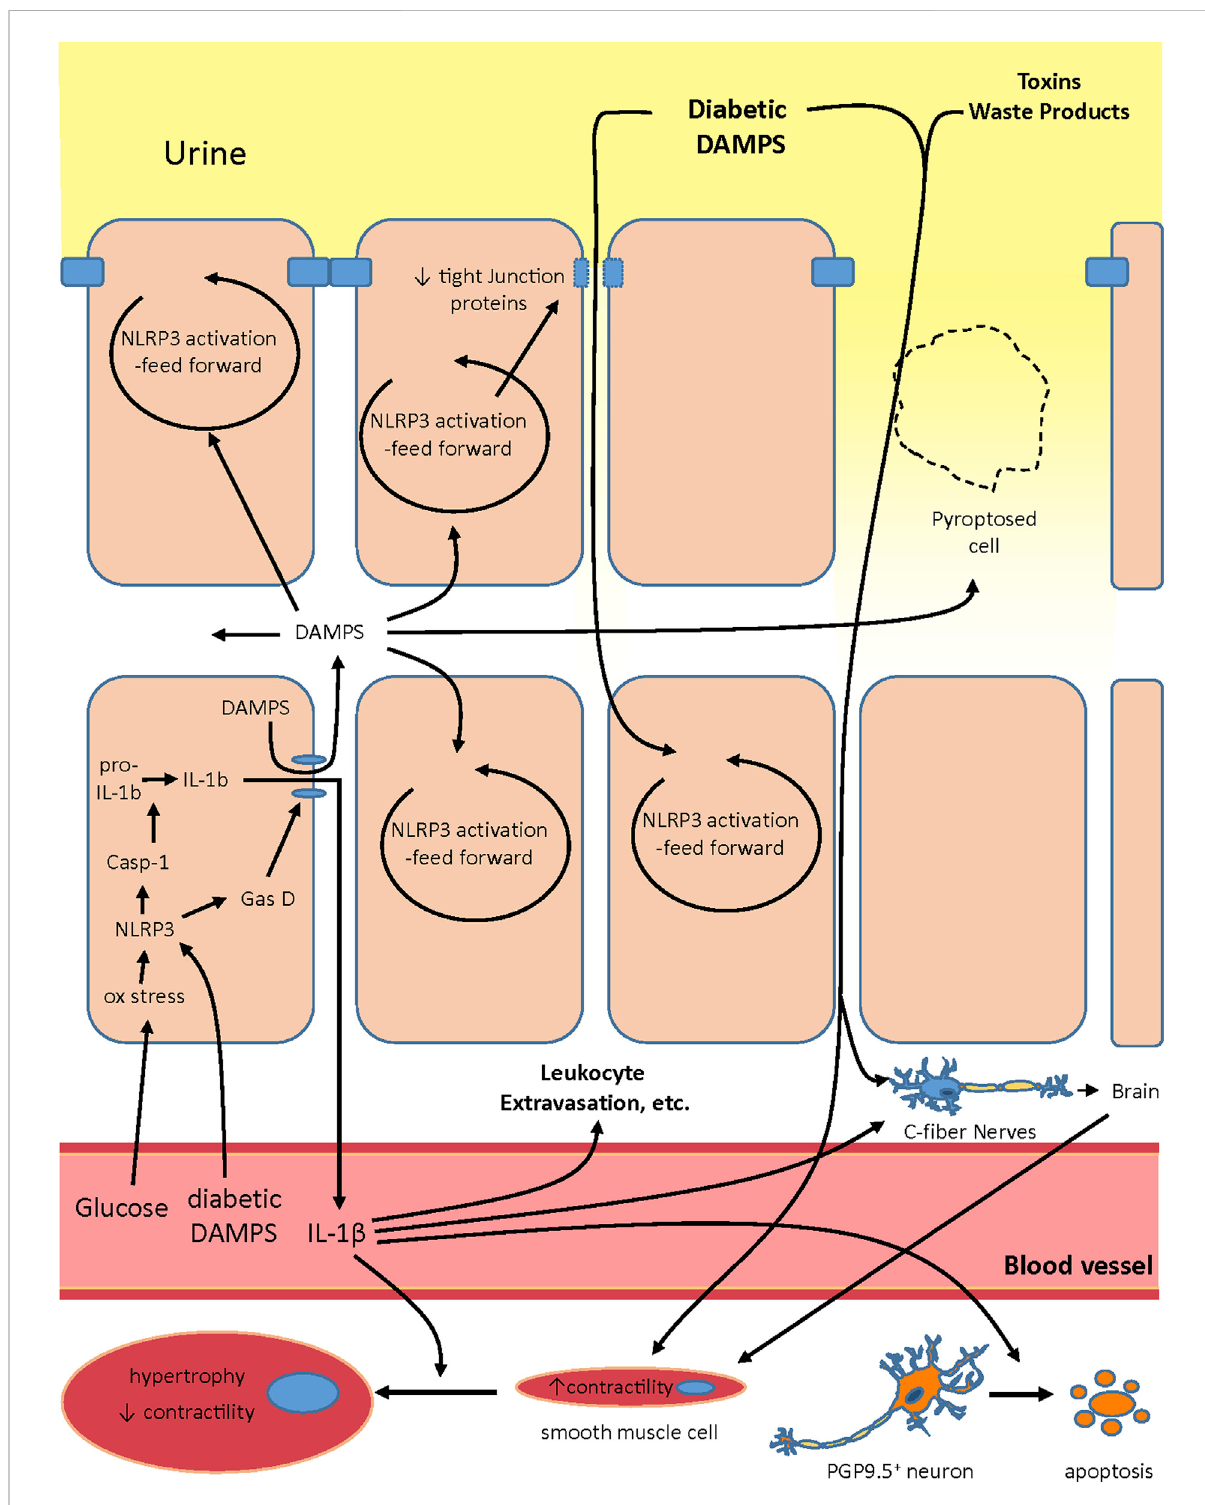
Proposed model of the role NLRP3 plays in creating both the overactive and underactive phase of DBD. Systemic glucose and diabetic DAMPS act in the urothelia to activate NLRP3 and pyroptosis. Pyroptosis then releases intracellular DAMPS that activate NLRP3 in neighboring cells in a feed forward fashion. In the super fi cial urothelia the feed forward NLRP3 activation also decreases expression of tight junctions. The decrease in tight junctions, along with “ holes ” in the super fi cial layer created by pryroptosing cells, decreases the barrier function of the urothelia and